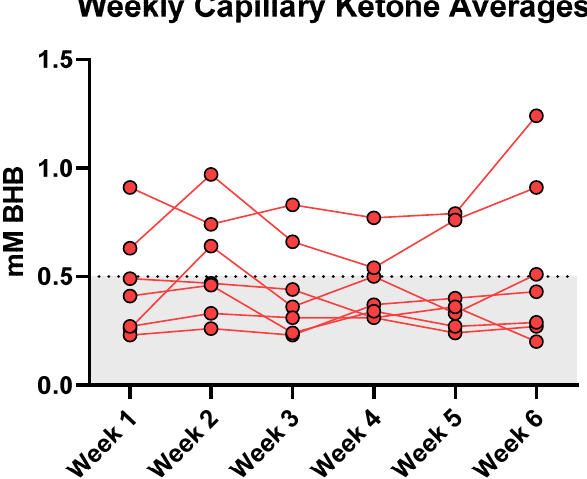
Figure 2. Fasted Capillary Ketone Responses. Each data point denotes a 7-day BHB average. The LCHF feeding phase modestly elevated circulating fasted BHB into the range of nutritional ketosis. Average weekly BHB plateaued at 0.5 ± 0.05 mmol/L (range: 0.20–1.24 mmol/L) over the six weeks. A 1 (condition) × 6 (time) RM ANOVA revealed that BHB concentrations remained stable over time from WK1 and thereafter ( p = 0.29).